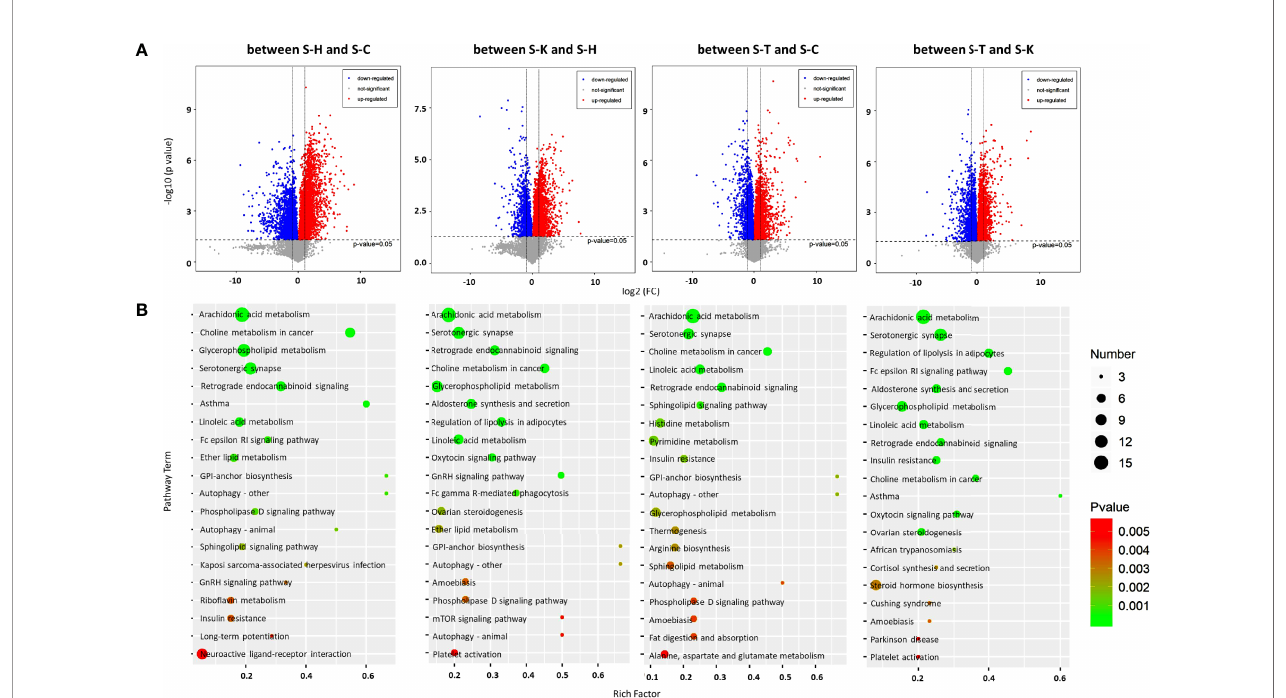
FIGURE 7 | Metabolomic analysis of the rat spleens. (A) Volcano plots were prepared by plotting the log (base 2) of the FC and p values of t-test results (base 10) for rat spleen metabolites between pairs of the four groups, including the healthy controls (S-H) (n=6), CIA rats (S-C) (n=6), CIA rats treated with 2-DG (S-T) (n=6), and healthy rats treated with 2-DG (S-K) (n=6). (B) The pathway analysis was performed based on the KEGG pathway database. The bubble charts show pathways that were enriched with DEMs in the spleen between the four rat